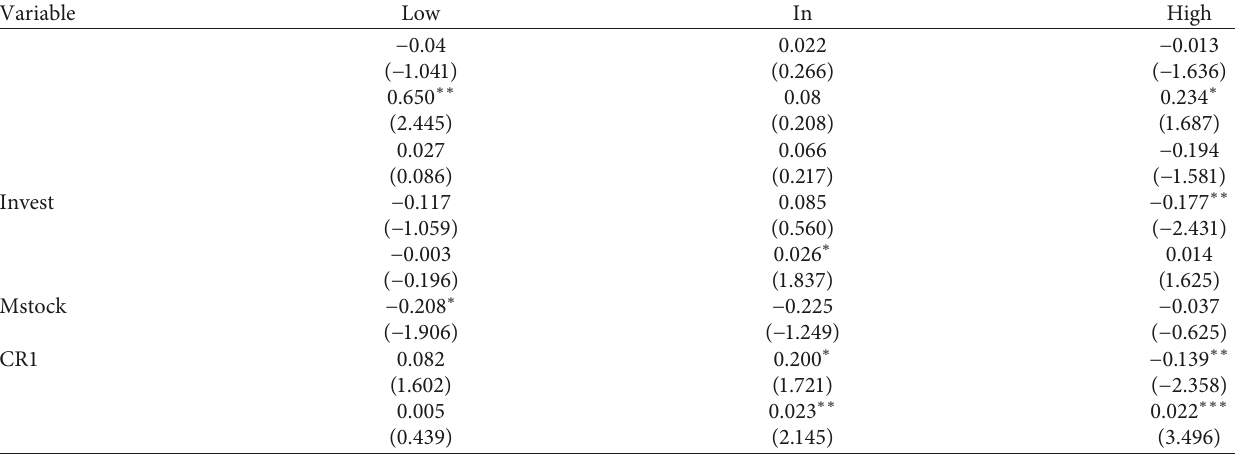
Table 6: Regression analysis of capital allocation efficiency and diversification degree under different levels of internal